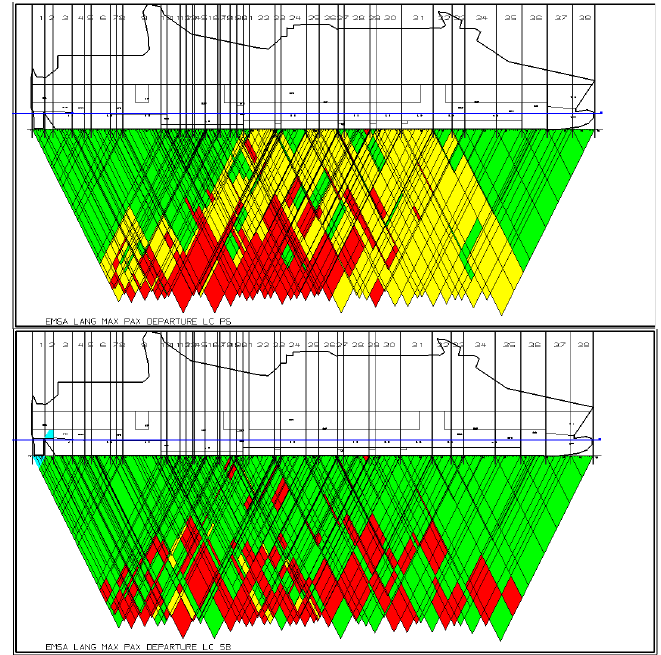
Figure 10. Output of the operational damage stability calculation for ps (left) and stb (right). GM = 3.70 m.